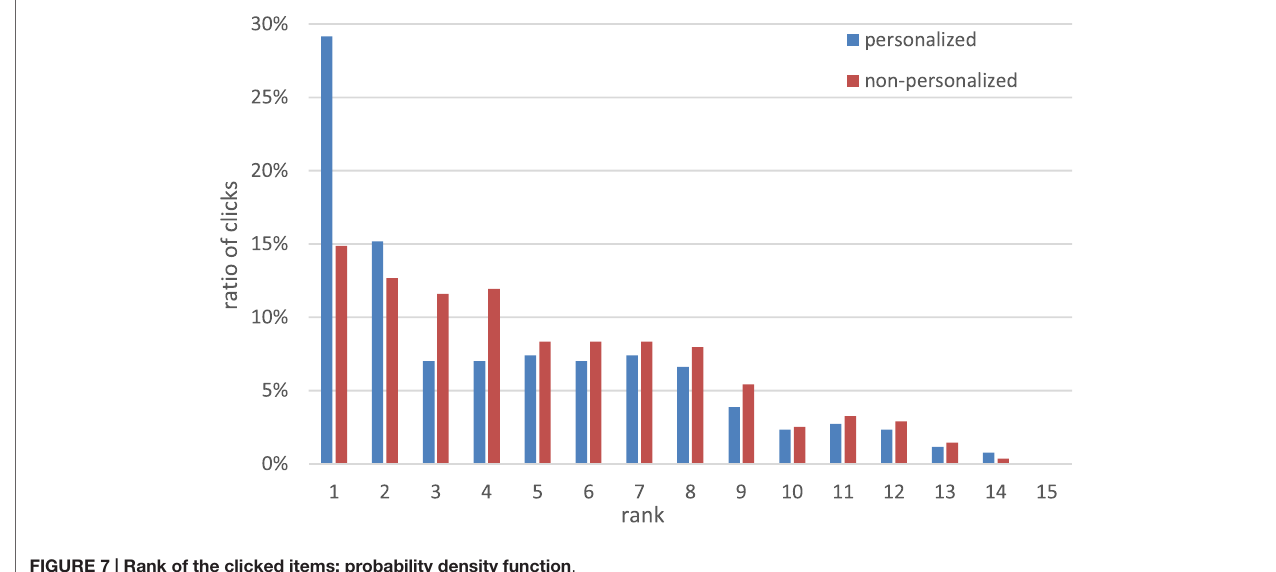
FigUre 7 | rank of the clicked items: probability density function .